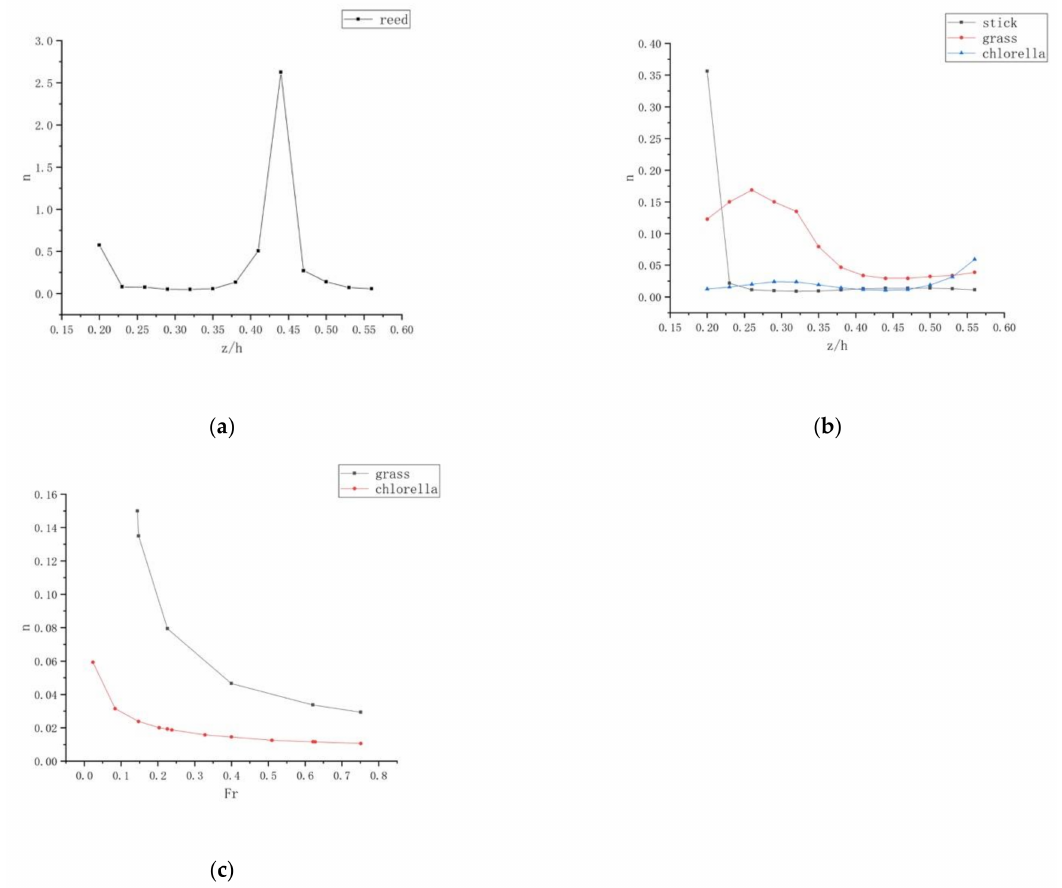
Figure 8. Manning coefficient n for various vegetations: ( a , b ): n against relative depth, z/h, where z is the height if measurement location, h is the water depth; ( c ) n against the Froude number,